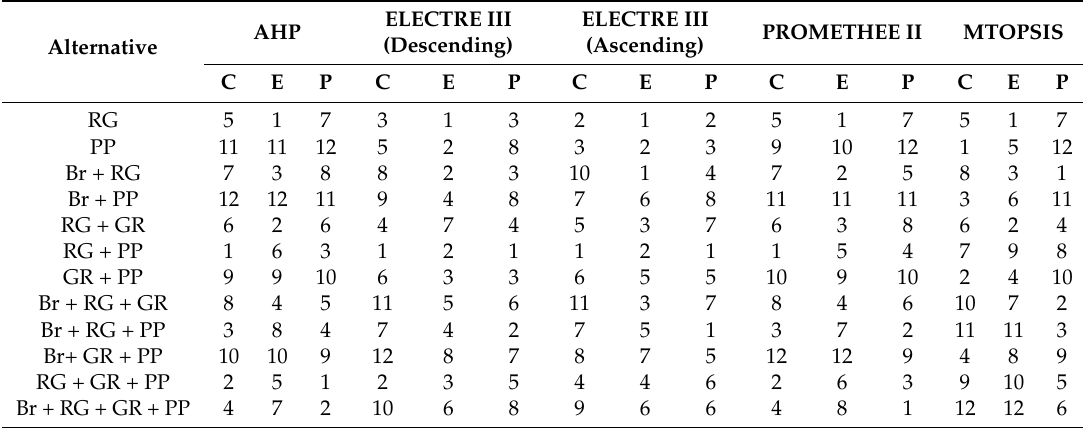
Table 12. Multi-criteria decision aid (MCDA) rankings for all stakeholders.